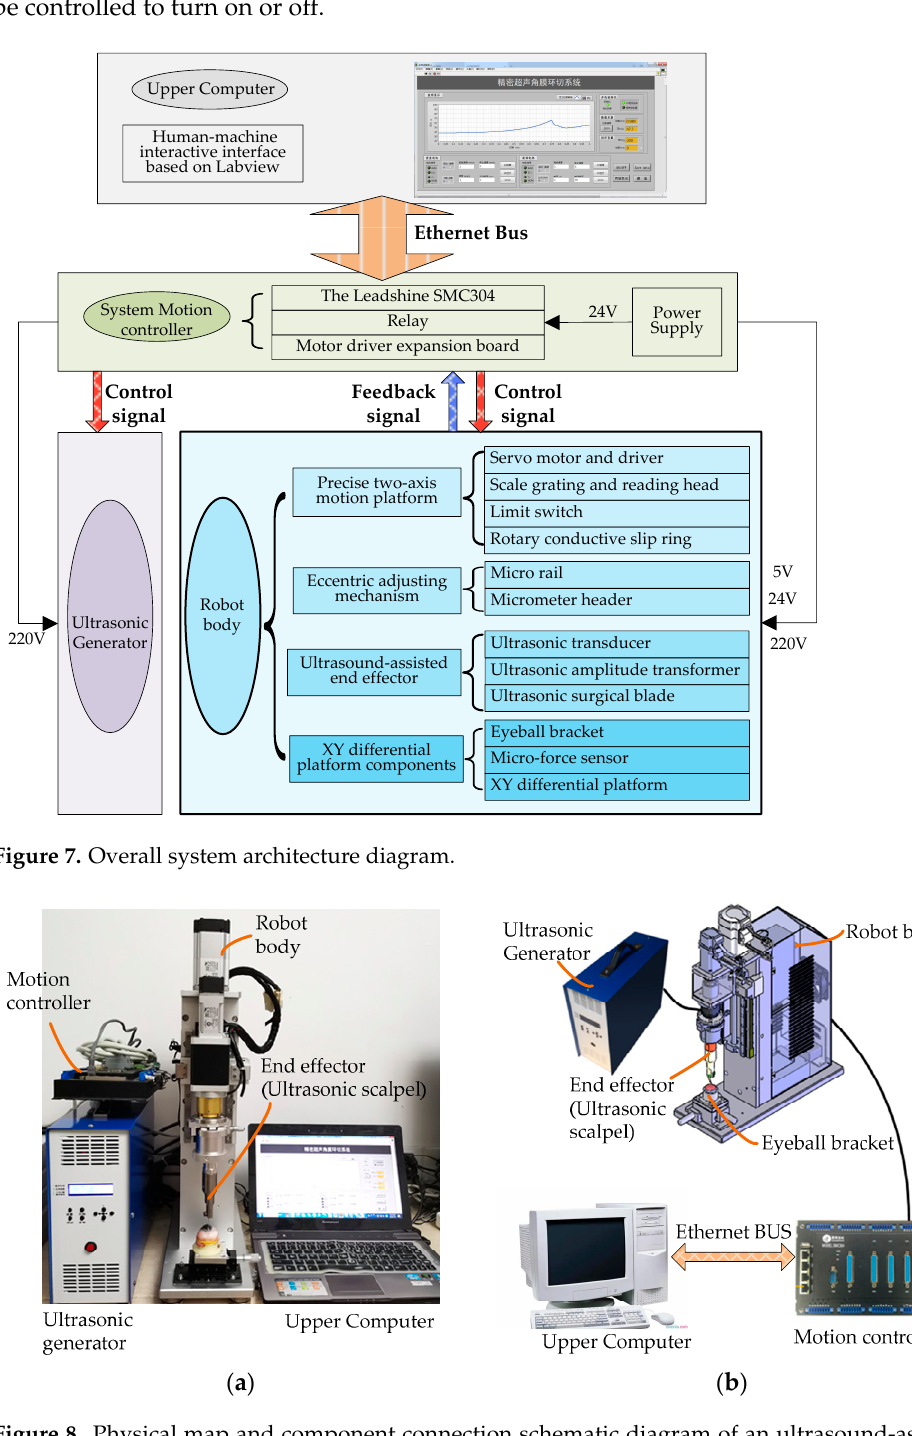
Figure 8. Physical map and component connection schematic diagram of an ultrasound-assisted corneal trephination system. ( a ) Physical map of the system. ( b ) System components ’ connection schematic diagram.